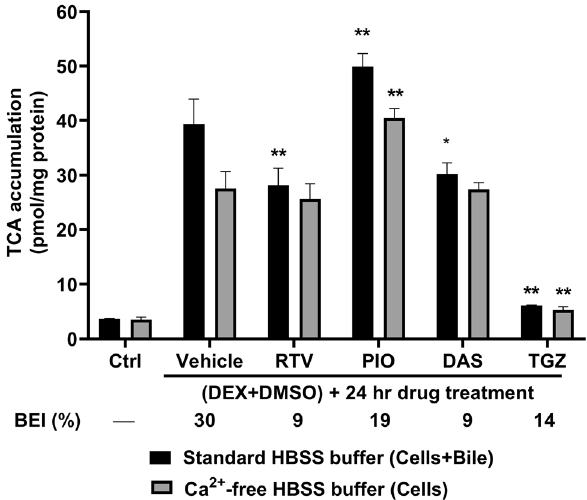
Figure 7. Effect of cholestatic drugs on the accumulation and biliary excretion index (BEI) of taurocholate (TCA) in control and differentiated HuH-7 cells with overlay. Accumulation and BEI of 2 µM [ 3 H]-TCA (200 nCi/mL) were measured in control (untreated; Ctrl) and differentiated (1 µM DEX + 0.5% DMSO) HuH-7 cells with overlay in standard or Ca 2+ -free HBSS buffer after a 24-h incubation with cholestatic drugs. On day 13 of culture, differentiated HuH-7 cells were exposed to 0.1% DMSO control (vehicle), ritonavir (RTV; 25 µM), pioglitazone (PIO; 100 µM), dasatinib (DAS; 20 µM), or troglitazone (TGZ; 75 µM) for 24 h. Data were plotted as mean ± standard deviation ( n = 3) and biliary excretion index (BEI, %) was calculated using Eq. (1). Statistically significant differences were measured using an ordinary two-way ANOVA with Dunnett’s multiple comparisons test (*, p < 0.05, **, p < 0.0001, vehicle control vs. drug